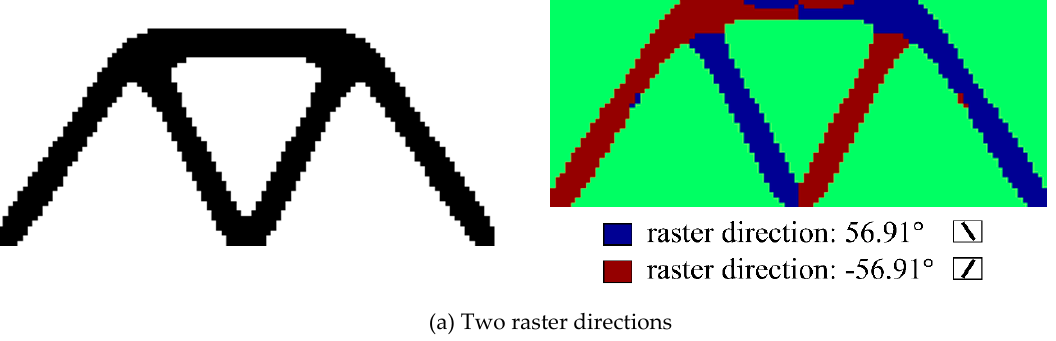
Figure 9. Schematic of the Michell structure problem definition.